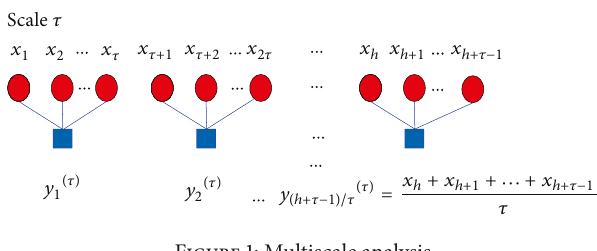
Figure 1: Multiscale